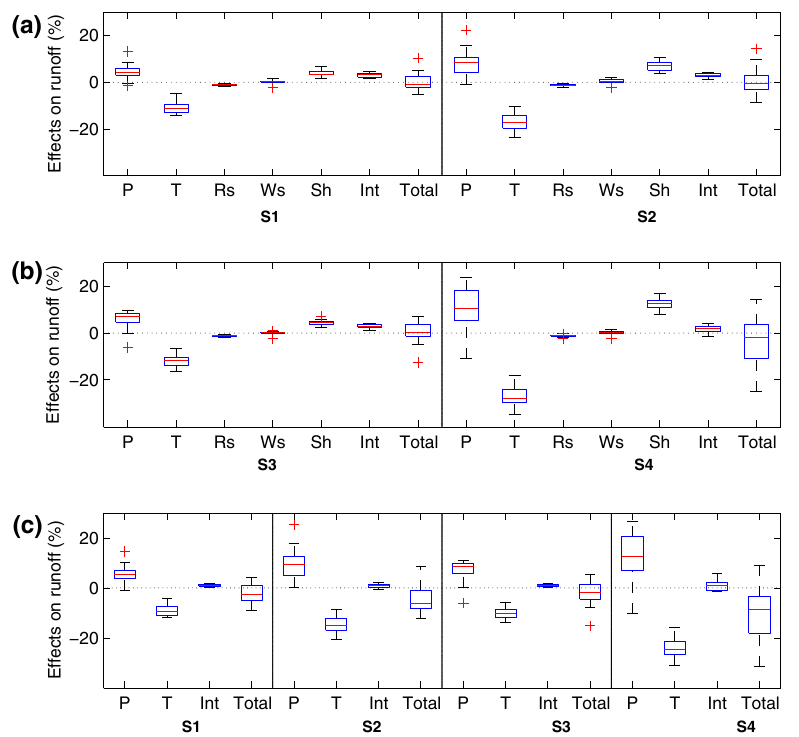
Figure 7. Independent effects of the climate variables over the conterminous United States (CONUS) in the future scenarios S1 (RCP4.5/2030s), S2 (RCP4.5/2080s), S3 (RCP8.5/2030s), and S4 (RCP8.5/2080s). (a, b) Effects of precipitation ( P ), temperature ( T ), solar radiation ( R s ), wind speed ( W s ), specific humidity (Sh), interactions among the variables (Int), and their sum (Total) on runoff based on the projections of Penman–Monteith PET. (c) Effects of precipitation ( P ), temperature ( T ), interaction between P and T (Int), and their sum (Total) on runoff based on the projections of Hamon PET. The format of the box–whisker plots is the same as that in Fig.